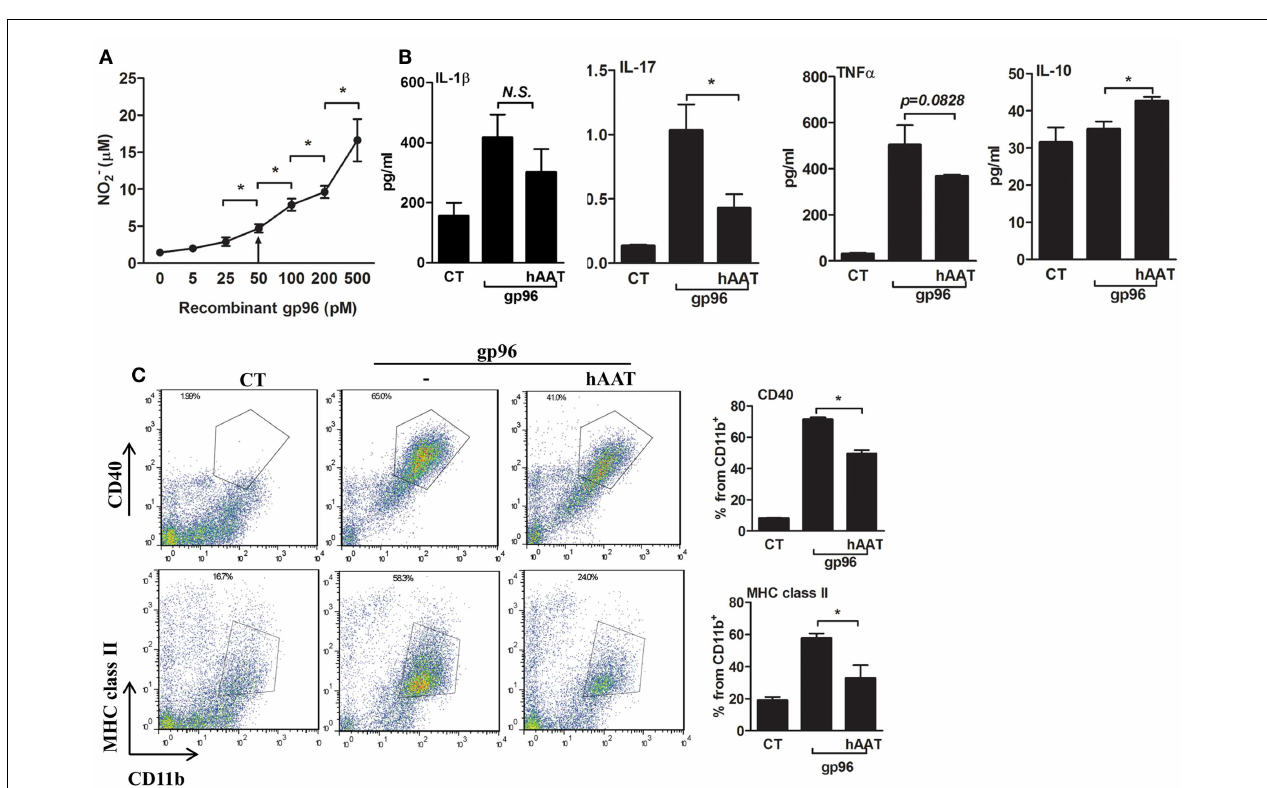
were incubated with recombinant gp96 (50pM) for 48h. Inflammatory mediators contained in the supernatants were measured by multiplex ELISA. CT, untreated cells. (C) Activation markers. Peritoneal macrophages (2 × 10 6 per well in quadruplicates) pretreated with human AAT (0.5mg/ml) were stimulated with recombinant gp96 (50pM) for 48h. Cells were then stained for surface markers. CT, untreated cells. Representative FACS dot plots, pooled results from three independent experiments. Mean ± SEM, * p <